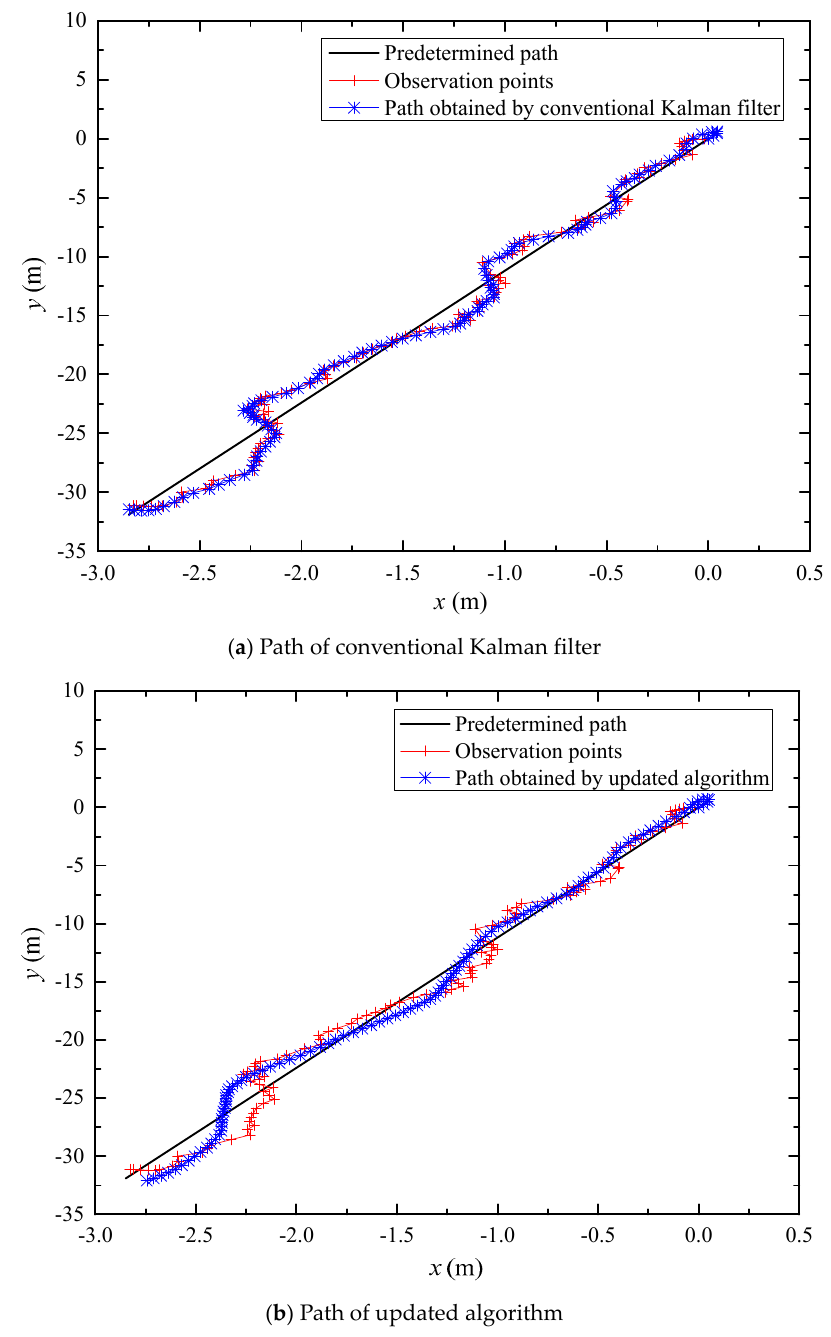
Figure 6. Path tracking for the conventional Kalman filter and updated algorithm.